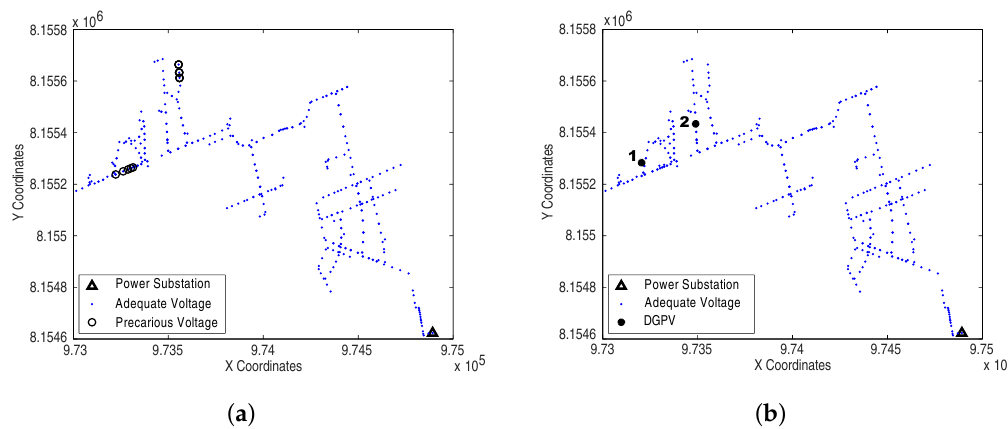
Figure 13. Scenario 2: ( a ) voltage rating before DGPV allocation and ( b ) voltage rating after DGPV allocation.